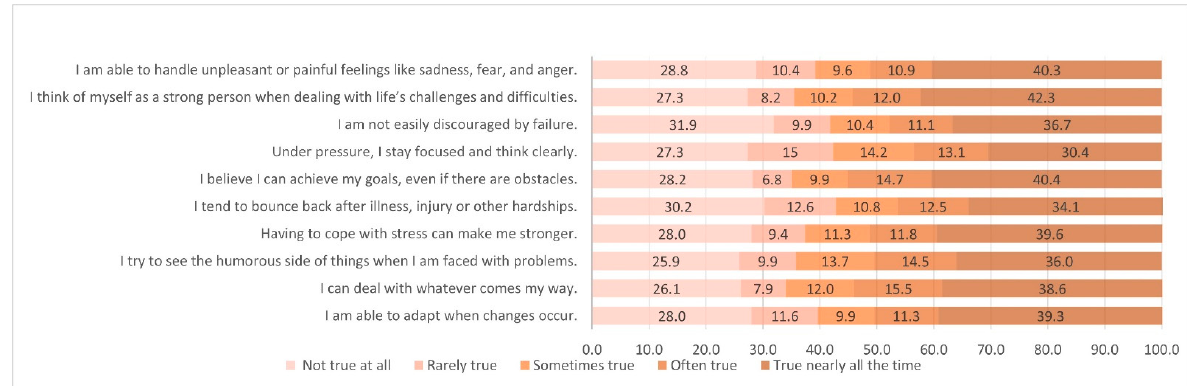
Figure 1. Distribution of responses from the short form of the CD-RISC. Military personnel with more than 18 months working in the first line of defense against COVID-19 had a 12.7% higher frequency of high level resilience, compared with military personnel whose working time was in the range 1 to 6 months (51.9% vs. 39.2%; p = 0.022). The remaining covariates were not statistically associated with resilience (Table 2).